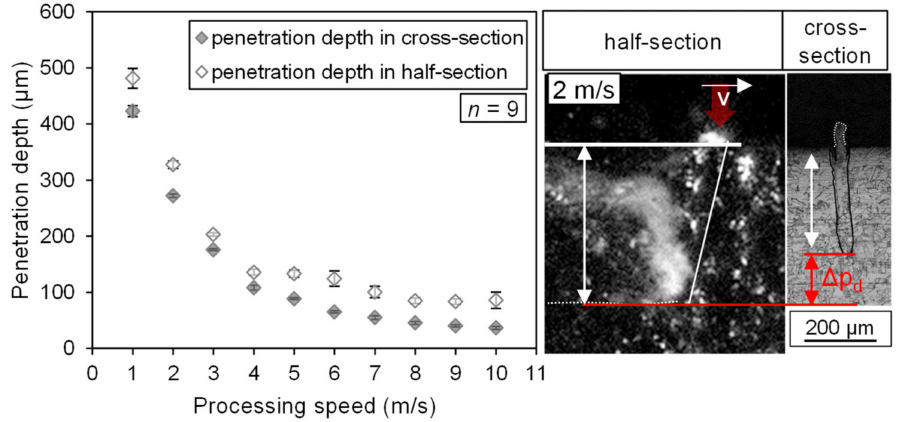
Figure 5. Resultant penetration depths in the cross-sections and half-section